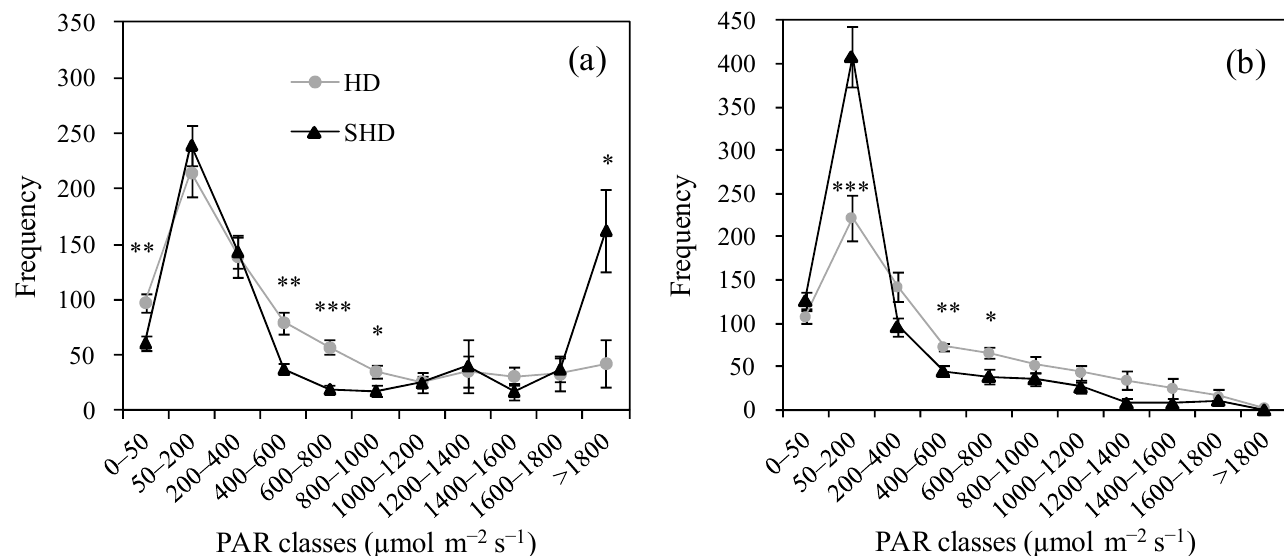
Figure 5. Class frequency distribution (mean of all available data) of transmitted PAR values as measured every minute, from dawn to dusk, as in Figure 4, but only for clear days, and for two positions along the transect, i.e., ( a ) the alley center (the position with the highest TPAR seasonal , 2.5 m from tree row in HD system and at 2 m in SHD, and ( b ) the position below the tree. Statistical significance between systems, within each position, was tested by analysis of variance (ANOVA, * = p < 0.05; ** = p < 0.01, *** = p < 0.001).